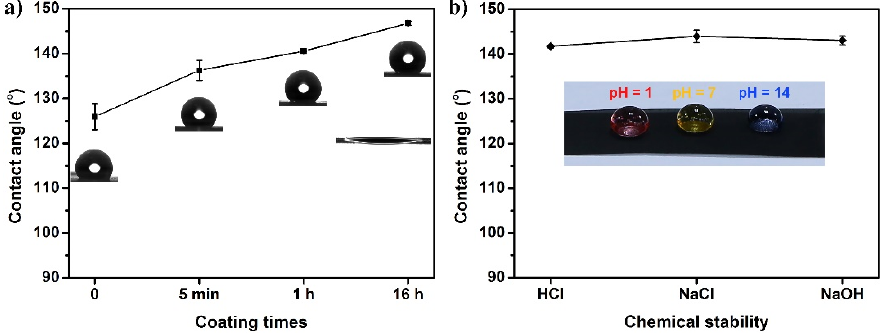
Figure 5. ( a ) Effect of coating times on CAs of the fabricated meshes. The insets show the corre- sponding CA optical images. ( b ) Influence of acidic, saline, and alkaline environments on the wet- ting behavior of the CS-coated mesh obtained at 16